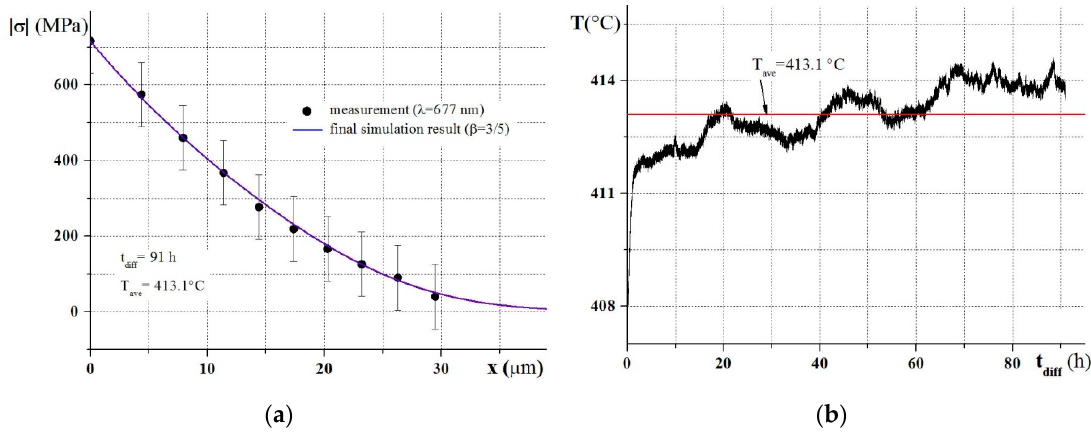
Figure 8. A comparison of the measurement results ( λ = 677nm) with simulation calculation of the σ ( x ) function a). The time course of the process temperature b).